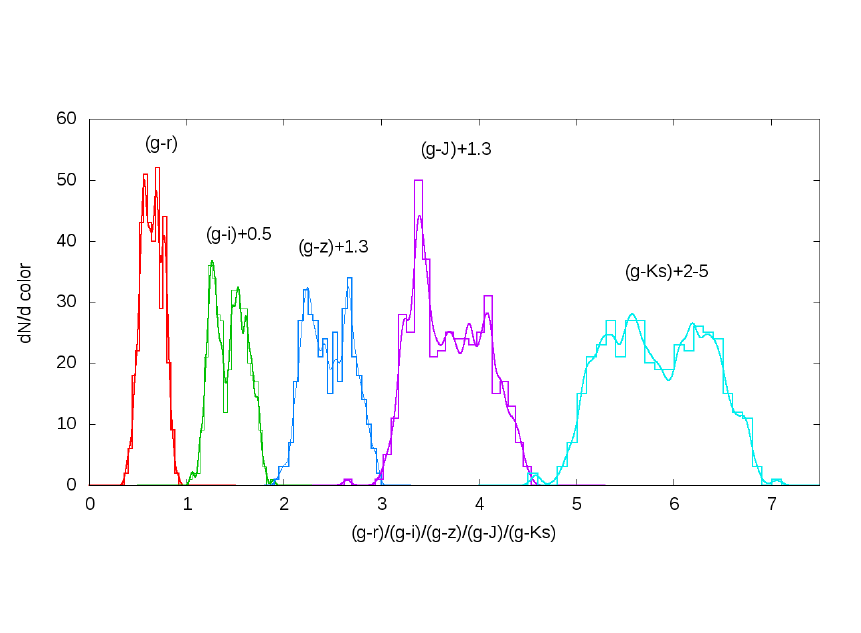
Figure 2. Histograms and density color distributions for different band combinations and for objects with g (cid:48) < 24 mag. The considered bins are in the range 0.04–0.1 mag. The density distributions were built using a Gaussian kernel with 0.02 < σ < 0.05 mag. To avoid superposition, we shifted some histograms by a constant value, as indicated in the figures.